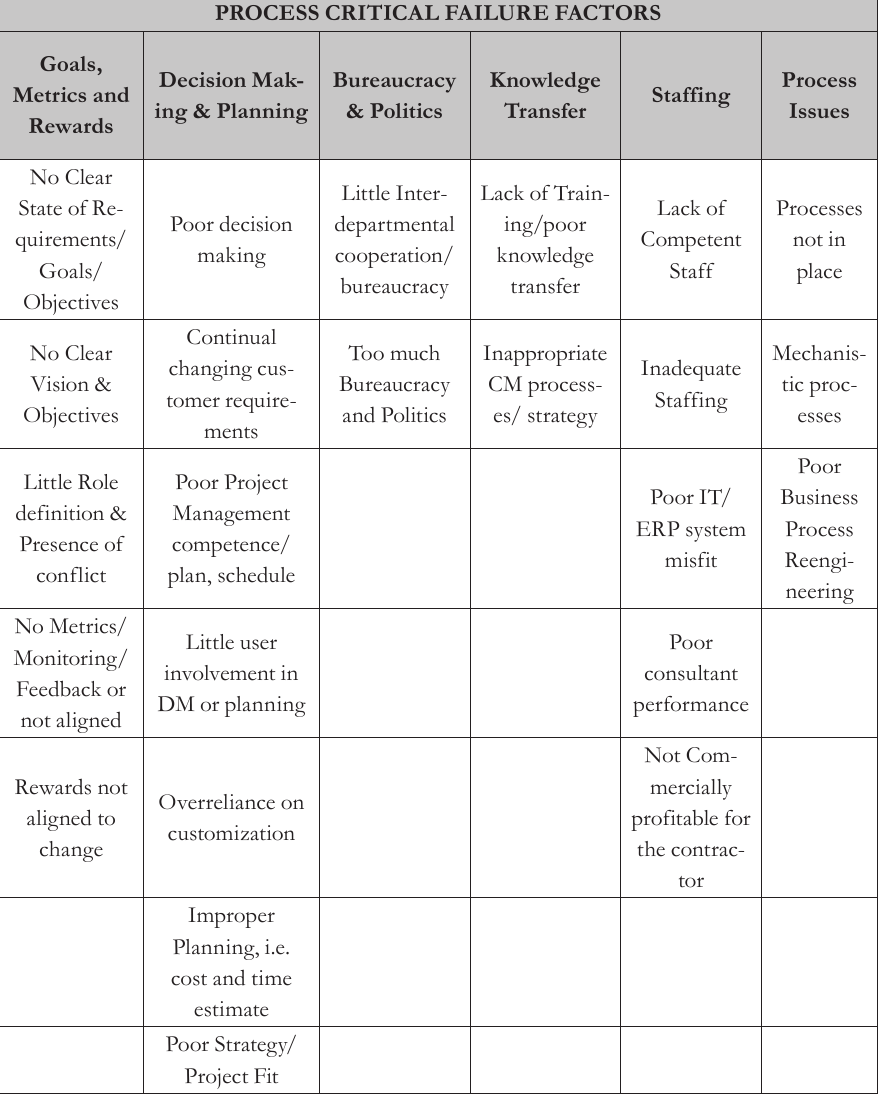
Tab. 1 - List of process critical failure factors. Source: Decker et al.